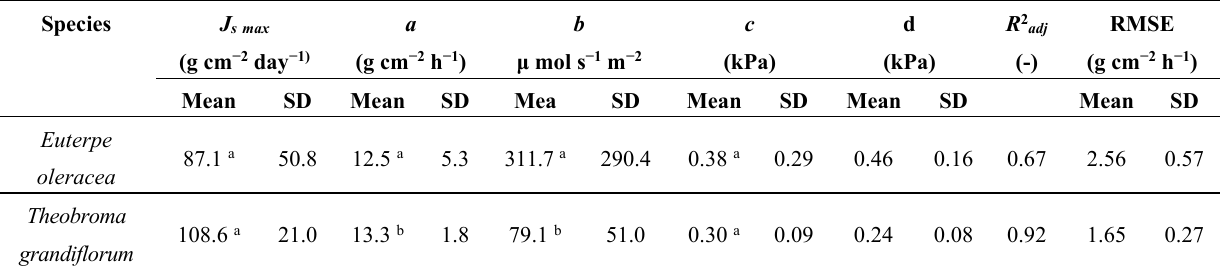
Table 2. Estimated daily mean sap flux density ( J s mean ), estimated model parameters ( a , b , c and d ) and measures of model performance (adjusted coefficient of determination ( R 2 adj ); root mean square error (RMSE)) for the two studied species (means and standard deviations (SD), n = 3 plant individuals). Significant differences ( p < 0.05) between species for the estimated sap flux density and individual model parameters are indicated by different superscripted